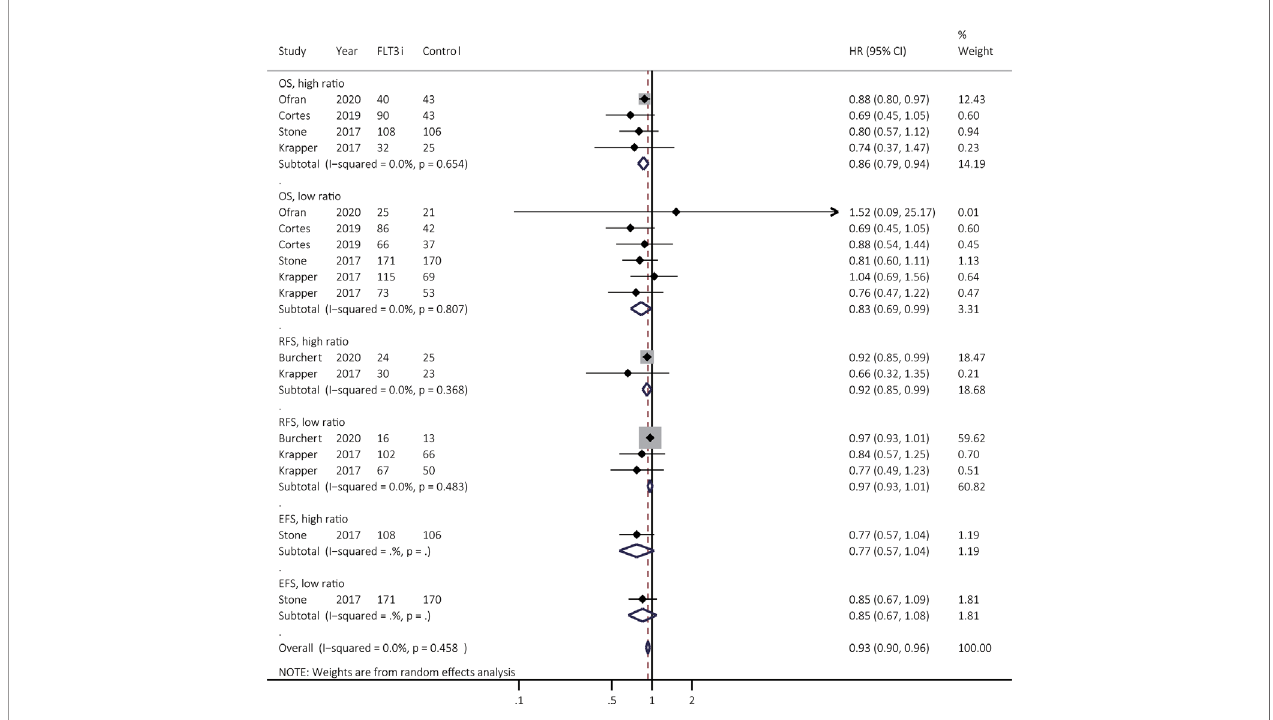
FIGURE 6 | Survival effectiveness of FLT3ito the FLT3-ITD allelic ratio. Except for the study fromStone et al. (3),high ratiowas identi fi ed as ≥ 0.5 as shownin the Supplementary Table 6 . In the study from Stone et al. (3),highratio was regarded as >0.7. FLT3, FMS-liketyrosine kinase3; FLT3i, FLT3 inhibitor; FLT3-ITD , FMS-like tyrosine kinase 3-internal tandem duplication; OS, overallsurvival; EFS, event-free survival; RFS, relapse-free survival; HR,hazard ratio; 95% CI, 95% con fi dence